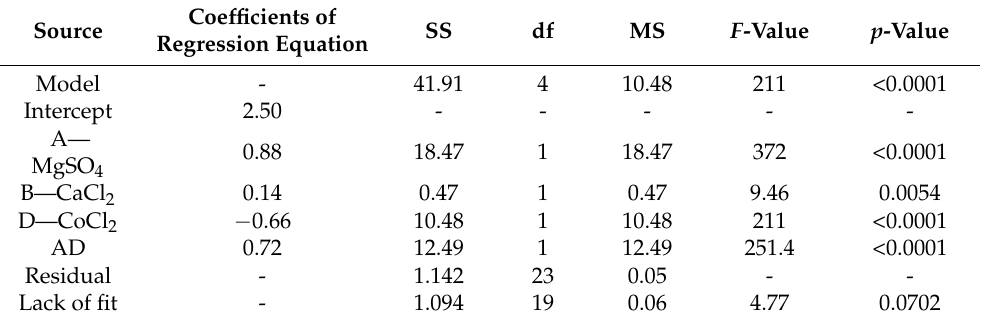
Table 4. Statistical analysis results according to ANOVA for Plackett–Burman